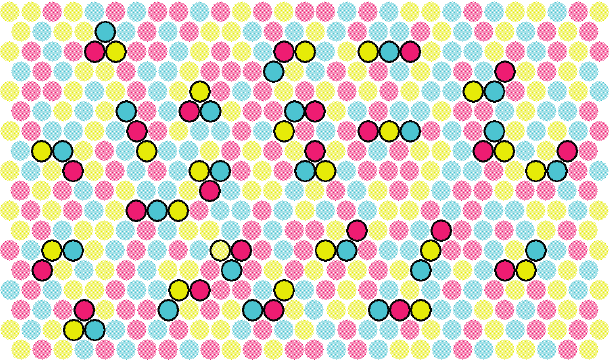
Figure 1. Representation of the distribution of amino acid headgroups on the surface of a micelle as described in reference [1], where the same combinations of amino acids can come together in many different configurations. One of these configurations will correspond to a structure with a desired biological